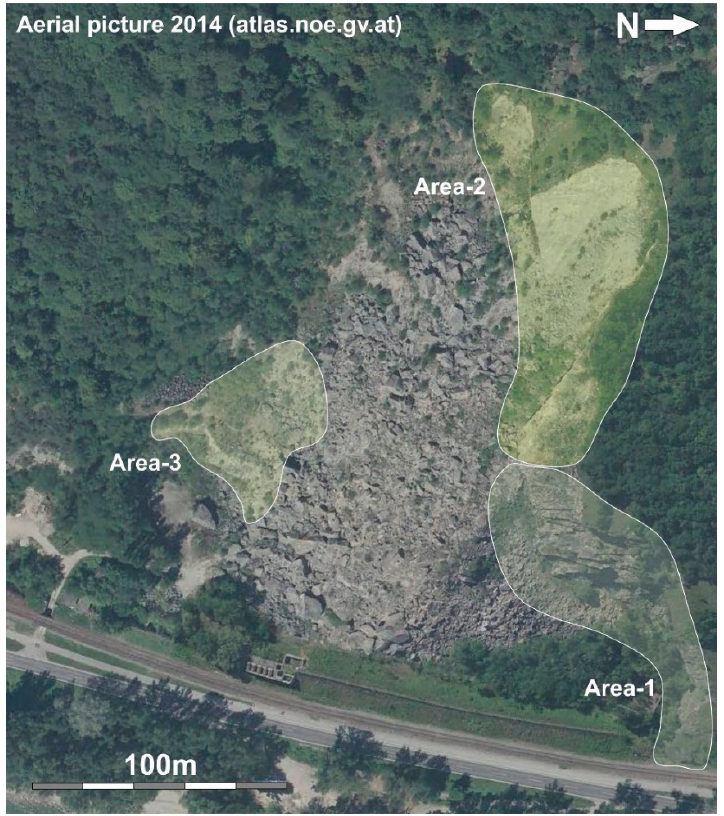
Figure 2. Areas of homogenous geological structure (aerial photo from 2014; from: [11]).